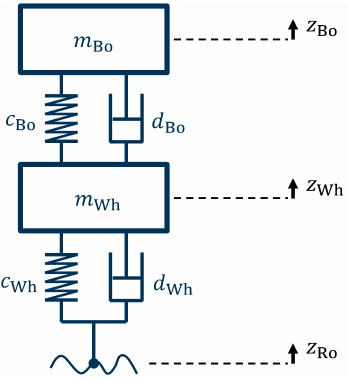
Figure 1. Quarter-vehicle model.